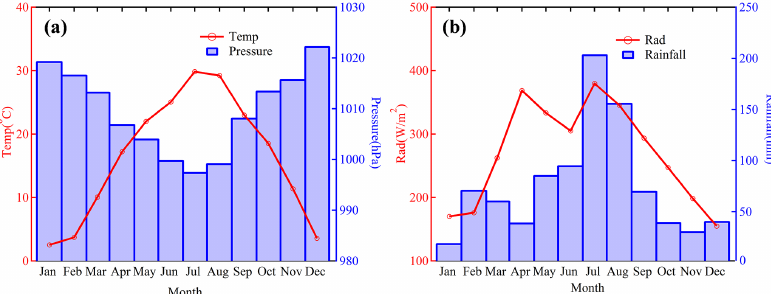
Figure 3. Averaged seasonal variations of (a) temperature and pressure and (b) radiation and rainfall during the entire measurement period.